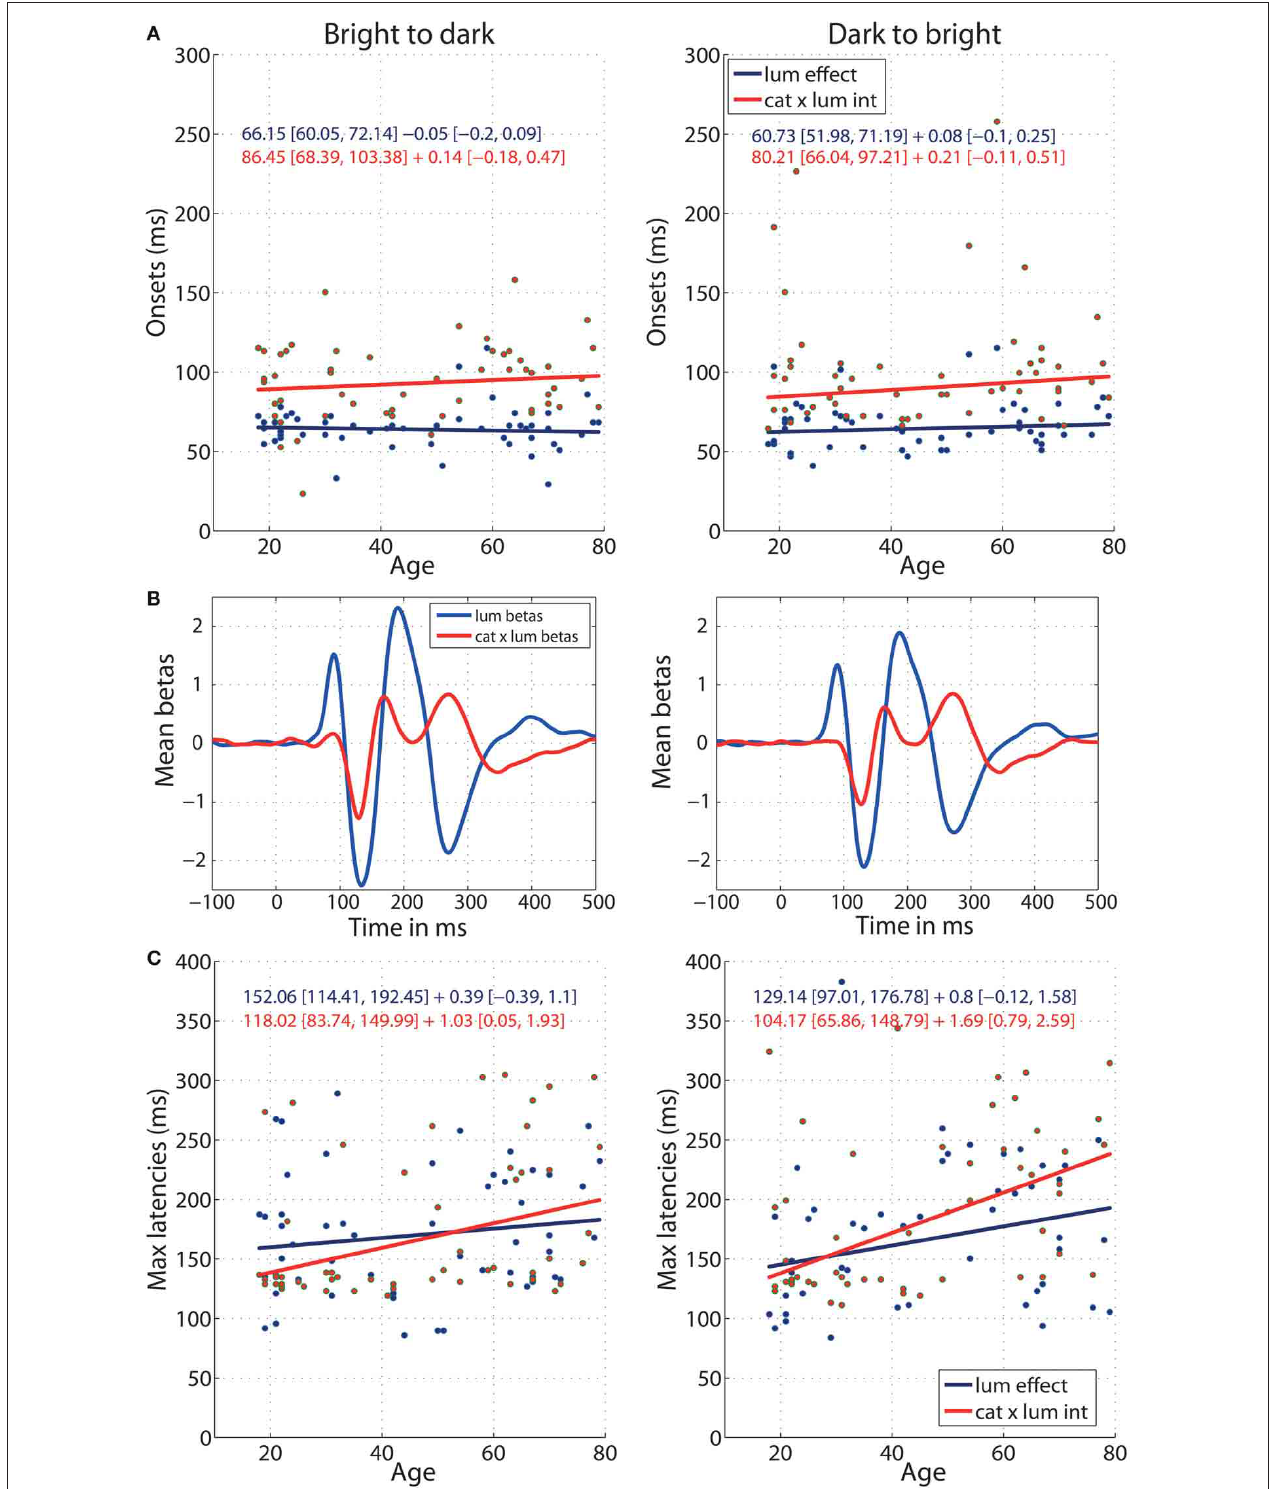
FIGURE 8 | Regressions of luminance effect and category × luminance interaction against age. (A) Onsets of the two effects against age for b2d (left column) and d2b sessions (right column). (B) Mean (across all subjects) beta coefficients associated with two predictors: luminance and category ×